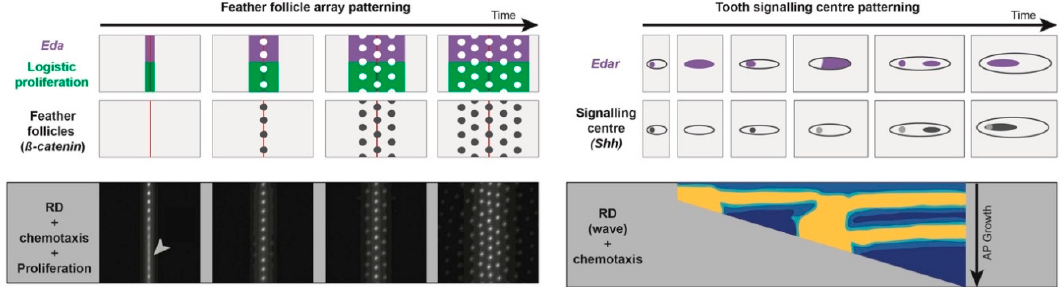
Figure 1. Similarities in molecular and cellular bases of patterning in different systems. During the patterning of both feather follicle arrays (marked by β -catenin expression) or tooth signalling centres (marked by Shh expression), Eda/EdaR allow visualizing morphogenetic waves, which are also characterised by a local increase in cell density and proliferation. In the first case, the wave travels along the medio-lateral axis, while in the second, timely regulation occurs during antero-posterior growth. Simulations of mathematical models composed of Turing-type reaction-diffusion, chemotaxis (and logistic proliferation in the case of follicles) can reproduce spatial dynamics of EdaR , Eda , or β -catenin expression and proliferation during tissue differentiation (high levels of β -catenin or EdaR expression respectively appear in white and yellow in simulations). Adapted from [37,41].